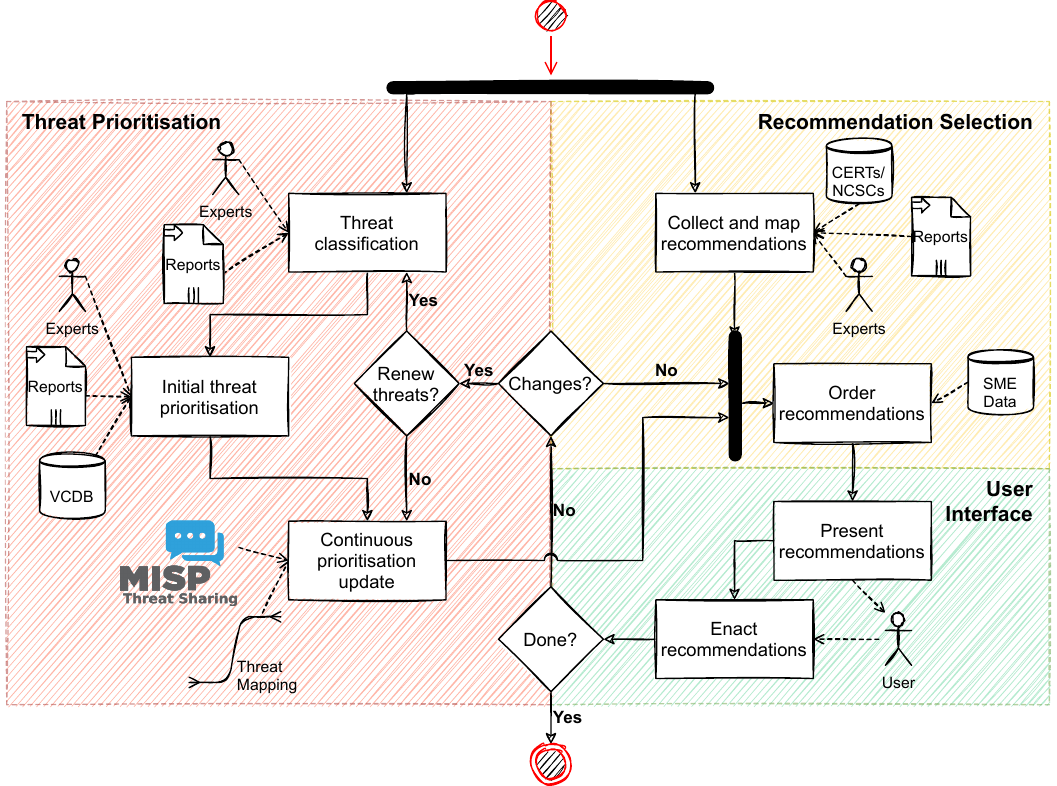
Figure 4. Process for turning shared CTI into actionable recommendations for SME